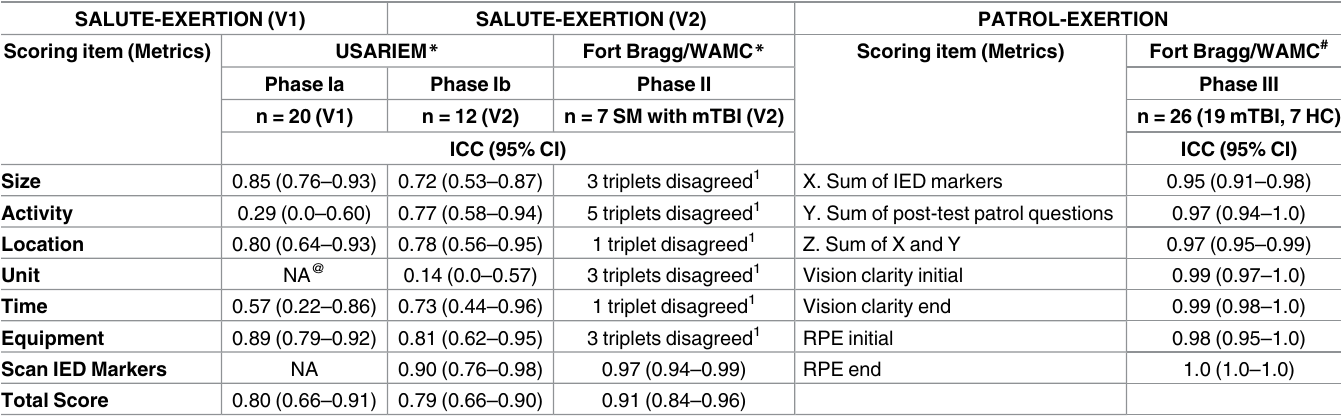
Table 6. Patrol-Exertion Interrater